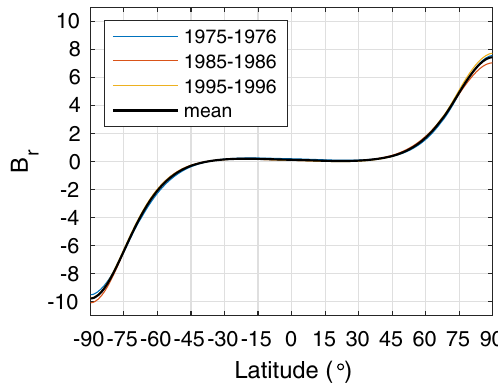
Fig. 3. Latitudinal distribution of the photospheric radial magnetic fi eld obtained from the best- fi tting two-dipole model for each of the three solar minima (1975 – 1976, 1985 – 1986 and 1995 – 1996). The radial magnetic fi eld has been normalized to the signed dipole term ( g 0 ) at each solar minimum to allow direct comparison. The mean 1 latitudinal pro fi le is plotted in